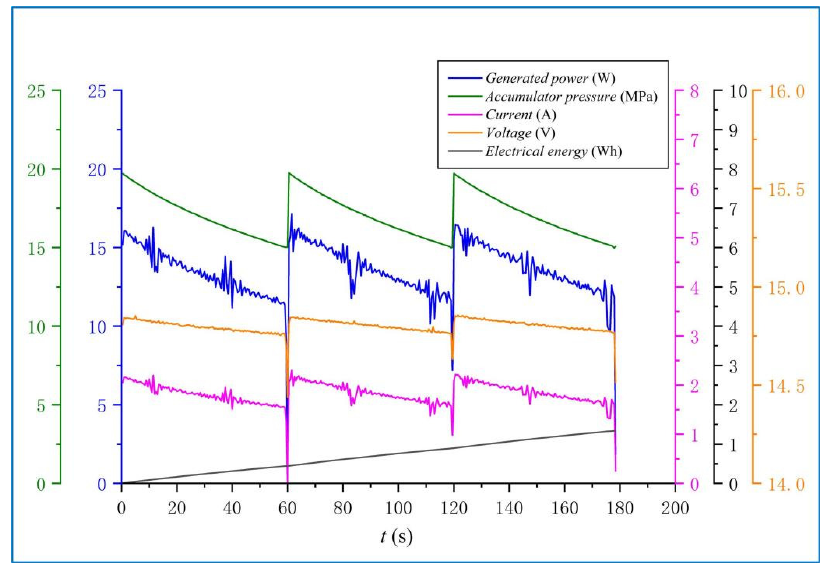
Figure 14. The power data in each of the three power generation cycles.